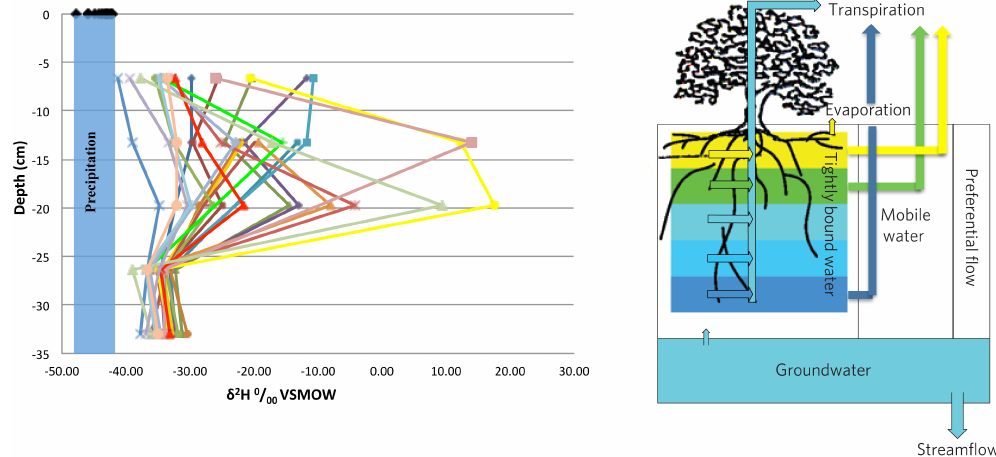
Figure 2. Left panel: soil water isotope profiles and evaporating front in a lysimeter experiment from a collection of soil samples from Sutanto et al. (2012); different colors represent different sampling periods. Right panel: a transpiration illustration from Brooks et al. (2010); different colors indicate different soil water isotopic values, with enriched isotopic values close to the surface and more depleted isotopic values in the bottom layers.